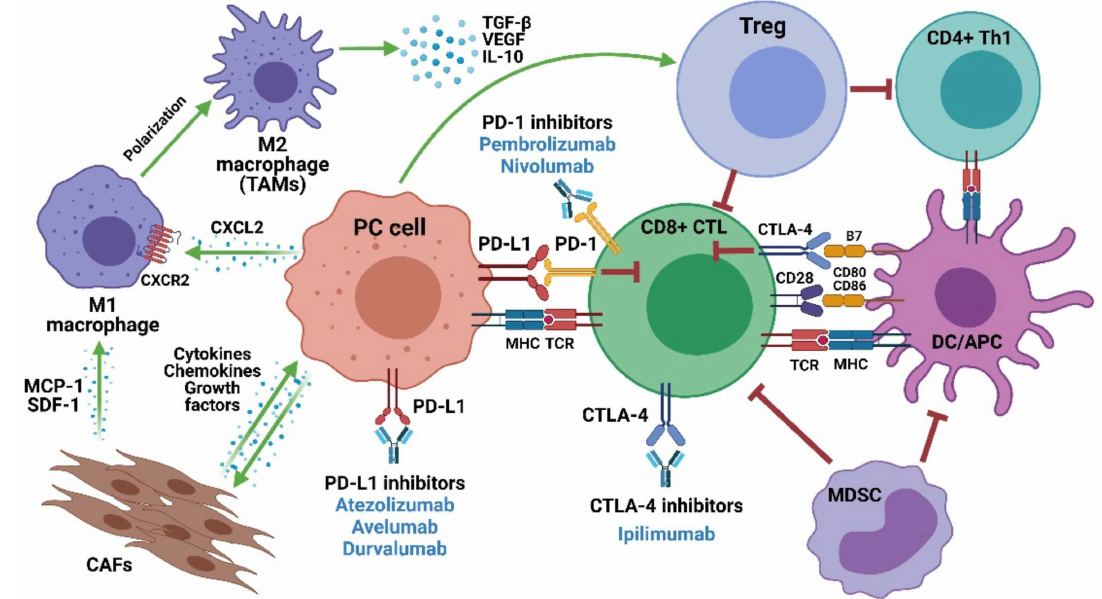
Figure 1. An overview of immune cell types involved in the PC TME and the molecular mechanisms of PD-1 and CTLA-4 attenuation of CD8+ T cell activation. APC: antigen-presenting cell; CAFs: cancer-associated fibroblasts; CD8 + CTL: CD8+ cytotoxic T lymphocyte; CD4 + Th1: type 1 CD4+ helper T; CTLA-4: cytotoxic T lymphocyte-associated protein 4; DC: dendritic cell; MDSC: myeloid-derived suppressor cell; MHC: histocompatibility complex; PC: prostate cancer; PD-L1: programmed death ligand 1; PD-1: programmed death 1; Treg: regulatory T cells; TAMs: tumor-associated macrophages; TCR: T cell receptor. Created with BioRender.com (accessed on 29 April